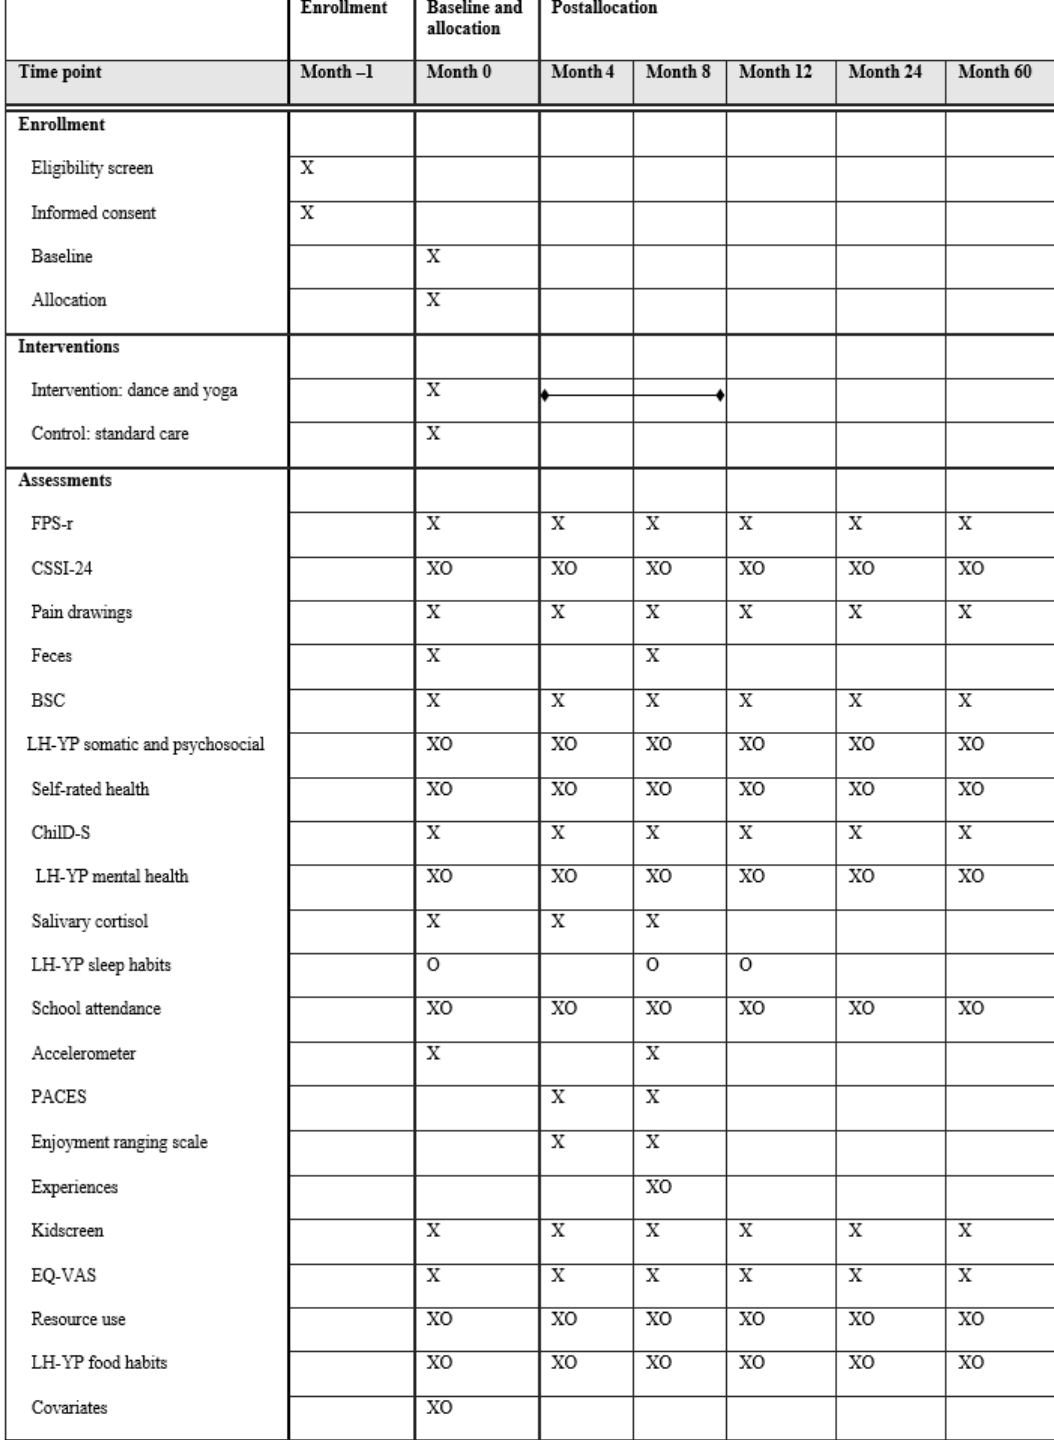
Figure 2. Enrollment, interventions, and assessments. An “X” represents a child report and an “O” represents a legal guardian report. The PACES, enjoyment rating scale, and experiences questions were only asked to the girls in the intervention group. BSC: Bristol stool chart; ChilD-S: Children’s Depression Screener; CSSI-24: Children’s Somatic Symptoms Inventory-24; EQ-VAS: EuroQol visual analog scale; FPS-r: faces pain scale-revised; LH-YP: Life and Health – Young People; PACES: Physical Activity Enjoyment